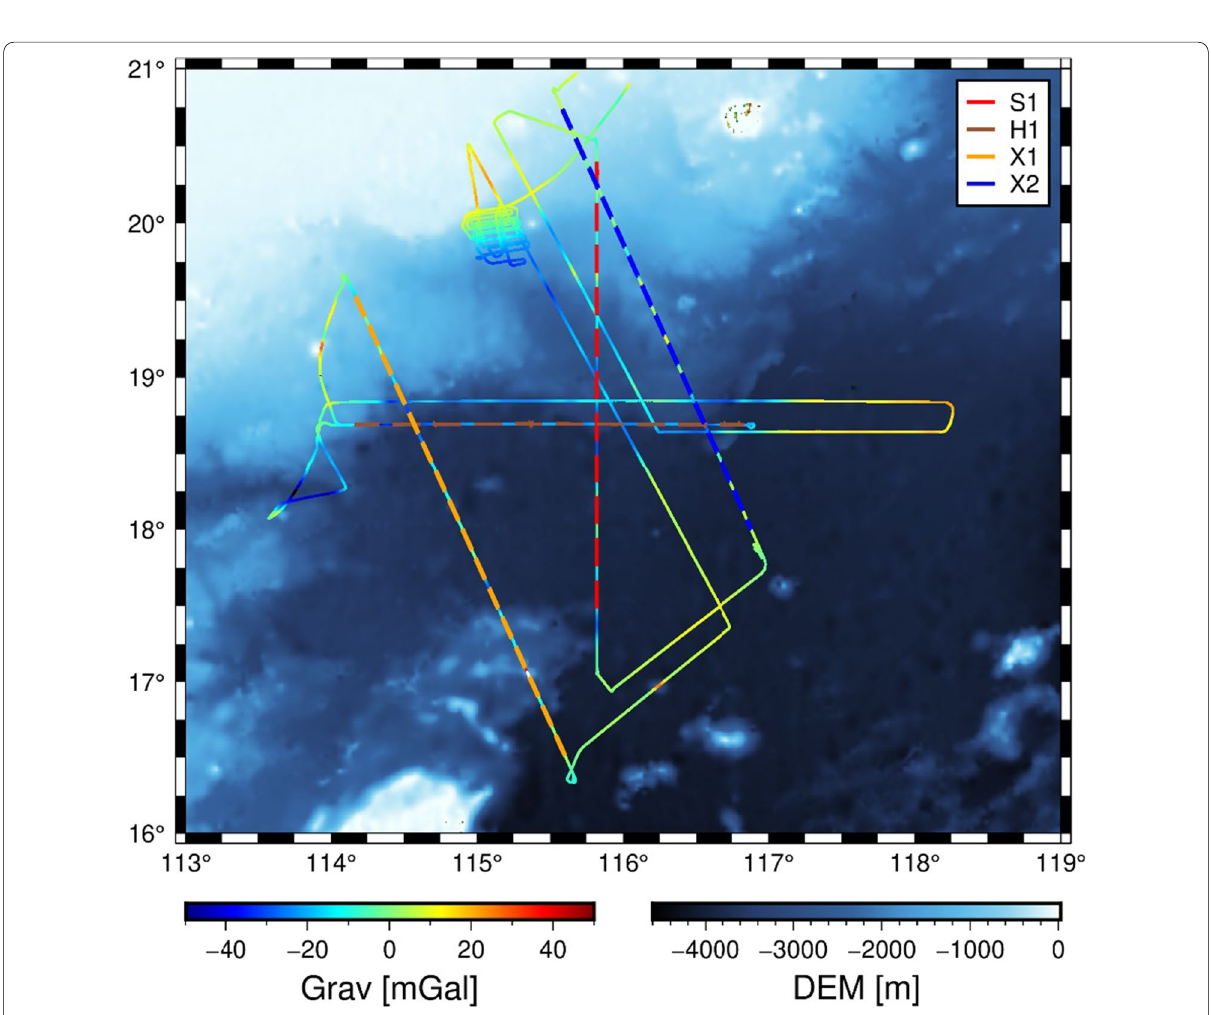
Fig. 3 Ship routes, repeat lines, and bathymetric depth